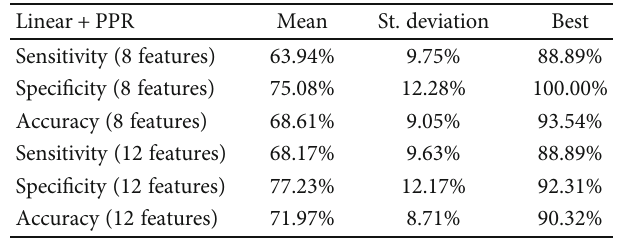
Table 12: Results of SVM with a linear kernel and